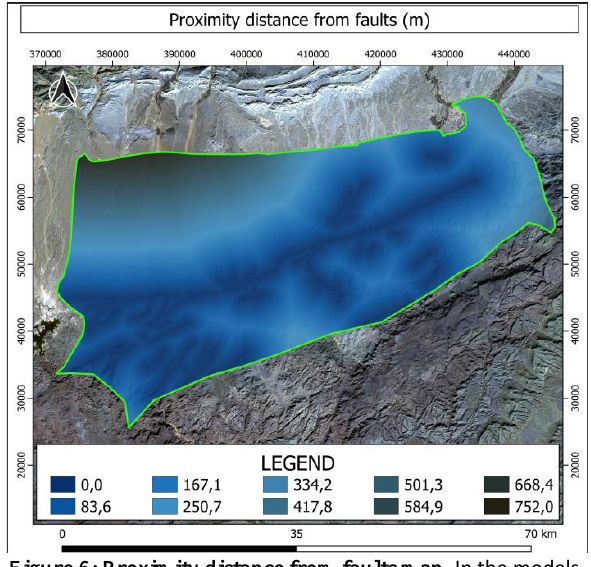
Figure 6: Proximity distance from faults map. In the models, labeled data was taken from the distance values at each pixel. 0 (meters) is the minimal distance, and 752 (meters) is the maximal distance.